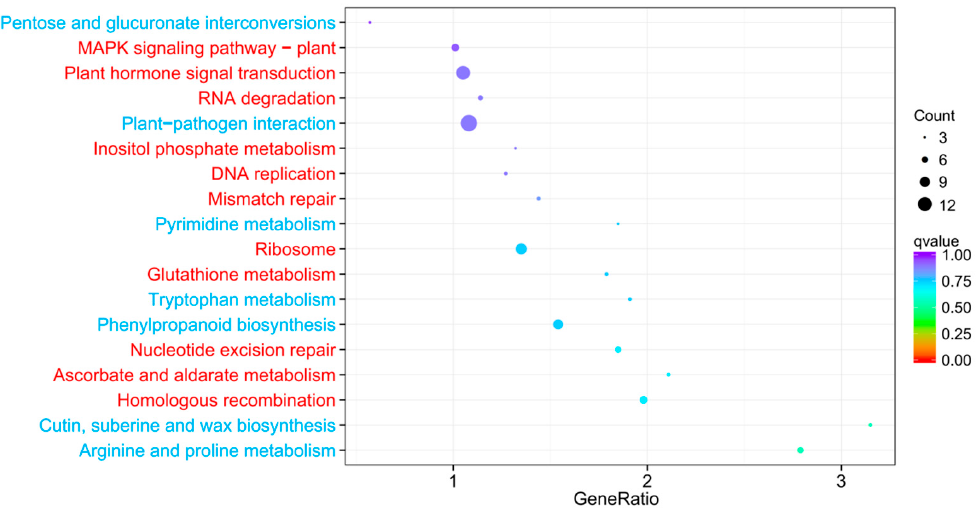
Figure 6. KEGG pathway enrichment analysis. The vertical axis represents the pathway name, and the horizontal axis represents the gene number ratio of significant DEGs to the total genes in a given KEGG pathway. The size of the dots indicated by “Count” represents the number of DEGs in the pathway, and the color of the dots corresponds to the different q-value ranges. The figure shows the top 18 pathways with q-values. Red and blue letters indicate more than 50% up-regulated and down-regulated DEGs out of a total number of DEGs, respectively.